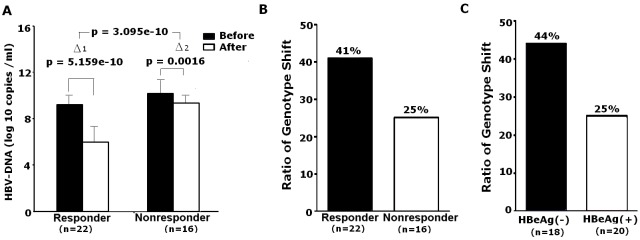
Genotype shifts correlated with selection pressure.(A) 38 patients were classified into the responder (HBV DNA load decreased by greater than 1x102 copies /ml after ADV treatment) and non-responder groups (DNA load decreased by less than lx102 copies /ml after ADV treatment). (B) Genotype shift was observed in 41% (9/22) of the responders and 25% (4/16) of non-responders, respectively. (C) The patients were divided into HBeAg-negative and HBeAg-positive group based on the level of HBeAg after drug treatment. Genotype shift was observed in 44% (8/18) of HBeAg-negative group and 25% (5/20) of HBeAg-positive group following the drug treatment.